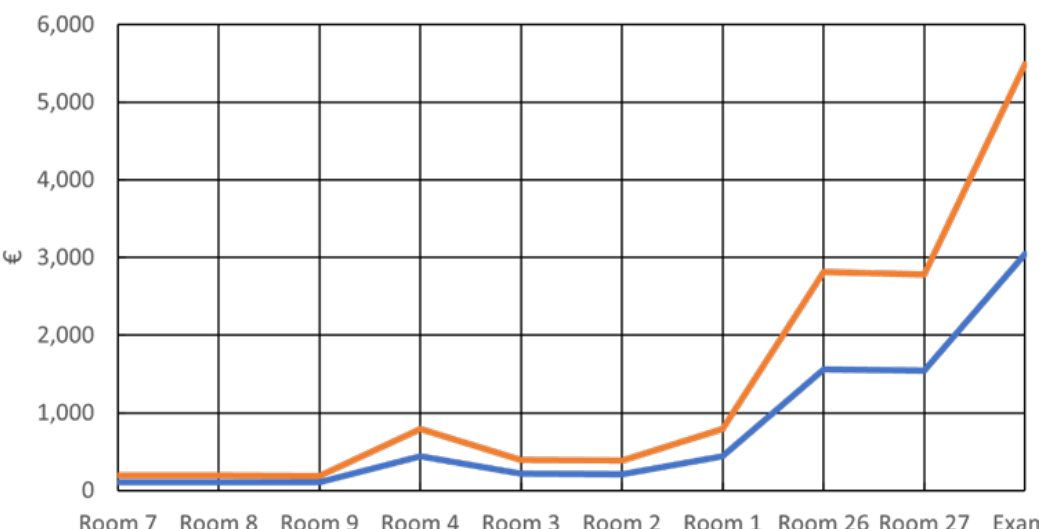
Figure 15. Annual cost savings per space.